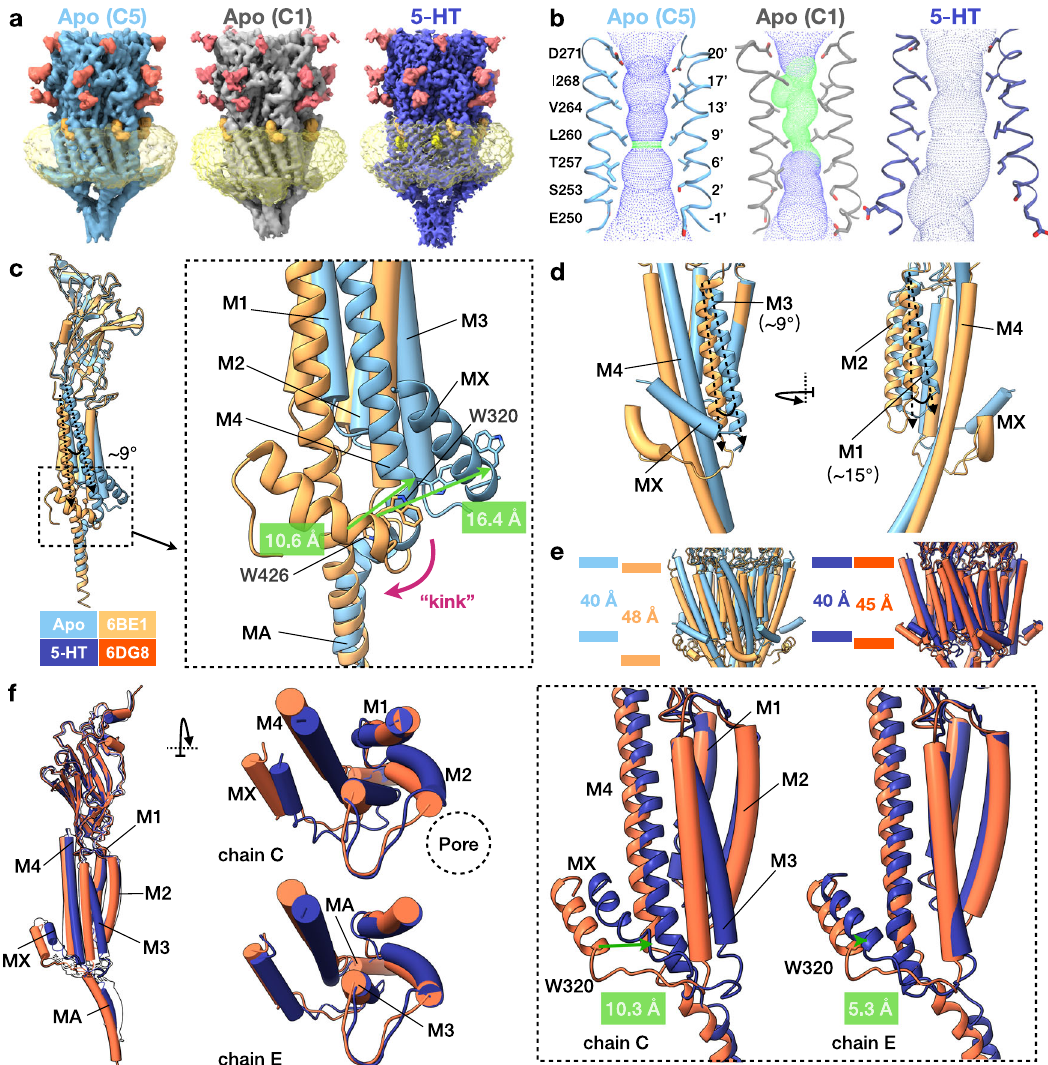
Fig. 1 Global architecture of 5HT 3 R-Salipro. a Cryo-EM maps of apo- (C5 symmetric, light blue; C1 symmetric, grey) and serotonin-5HT 3 R-Salipro (5-HT, dark blue), with red, orange, yellow and transparent-yellow densities corresponding to glycosylation, cholesterol, inter-subunit phospholipids and the saposin-lipid bilayer, respectively. b Static pore radius of the 5HT 3 R-Salipro models determined using HOLE 64 . Green and blue spheres represent radii of 1.8 – 3.3 Å, and >3.3 Å, respectively. c , d Superposition of the apo-5HT 3 R-Salipro (C5) and apo-5HT 3 R-detergent (6BE1, yellow) structures (single subunit is shown for clarity). Differences at the c MX and M4-MA helices, and d M1 and M3 helices are highlighted. e The TMD thickness was measured between residues L221 and W426 for the 5HT 3 R-Salipro and the 5HT 3 R-detergent structures (coloured as in c and f ). f Superposition of the monomers of the serotonin-5HT 3 R-Salipro and serotonin-5HT 3 R-detergent (6DG8, orange) structures. The left panel shows chain C in colour and black silhouettes for the other chains. The middle panel shows a top view of the TMD. Right panel highlights differences in the position of MX (8.2, 6.7, 10.3, 7.0 and 5.3 Å measured at the C α atom of W320 of chains A – E, respectively). Chains C and E represent the most and least different subunits, Global architecture of 5HT 3 R-Salipro structures . Both the apo- data set, with 61% of particles falling into the C5 symmetric class and 39% into the asymmetric class. Furthermore, the symmetric and serotonin-5HT 3 R-Salipro conformations differ substantially from the previously reported detergent-solubilised structures and asymmetric apo states showed globally similar conforma- (Fig. 1c – f and Supplementary Movie 1) 15 – 18 . To assess the effect tions, that differed mostly in the relative positioning of the TMDs of lipids on the receptor, the cryo-EM-derived models with PDB of the different subunits (Supplementary Table 2, and discussed accession codes 6BE1 and 6DG8 are used as references for the below). Thus, unless stated otherwise, the main symmetric apo apo and serotonin-bound states in detergent (apo-5HT 3 R- conformation (referred to as apo-5HT 3 R-Salipro) is used in subsequent analyses. detergent and serotonin-5HT 3 R-detergent), respectively, as they were solved in the absence of any exogenously added lipids 16,18 . In the apo state, the lipid-facing M1, M3, and M4 helices of 5HT 3 R-Salipro are signi fi cantly tilted compared to their positions in detergent. The largest displacement is observed for M4 which is tilted by ~9°, displacing W426 on the intracellular side by 10.6 Å (Fig. 1c). The MX helices were shifted by 16.4 Å (measured